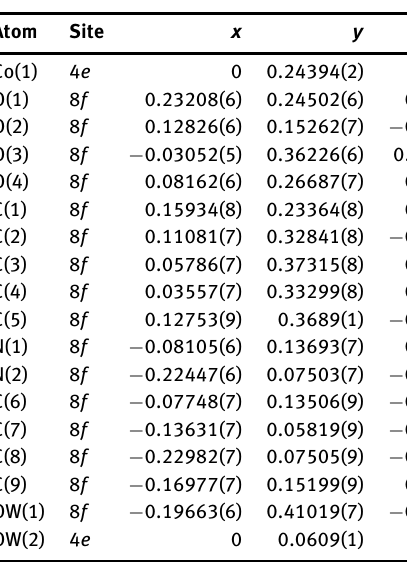
Table 3: Atomic displacement parameters (Å 2